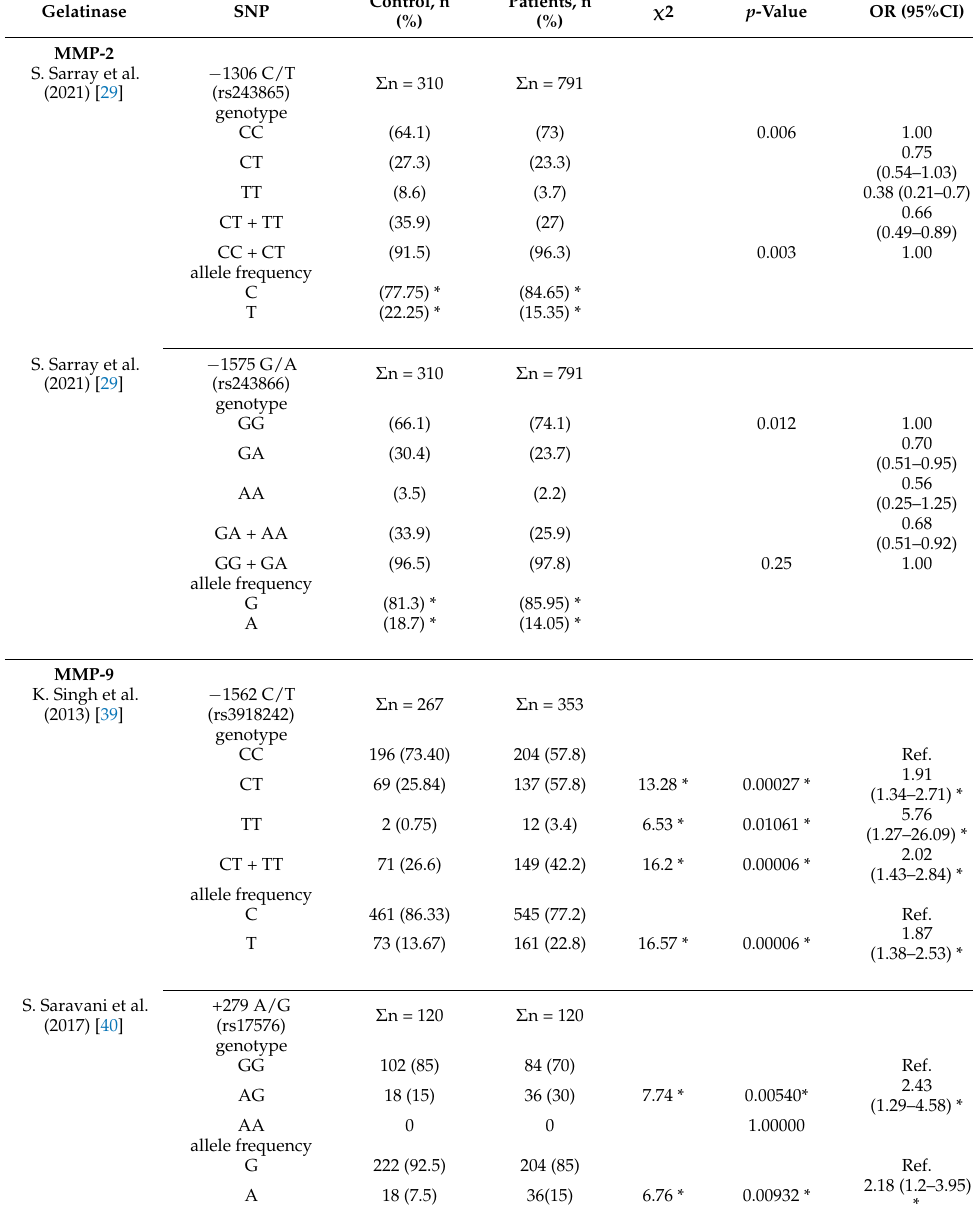
Table 2. Comparison of the frequency of genotypes and alleles of individual polymorphisms of MMP-2 and MMP-9 polymorphisms for control groups and patients with type 2